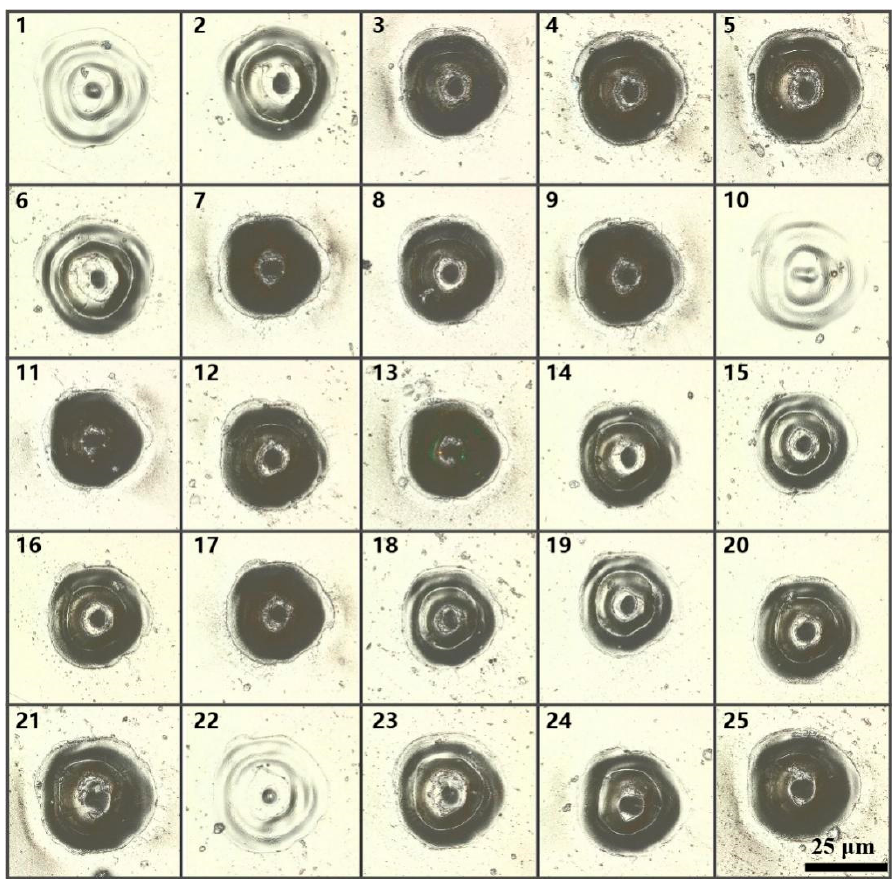
Figure 3. Typical confocal microscope image of each sample. Table 4. Experimental results L 25 (5 3 ) orthogonal experiments.